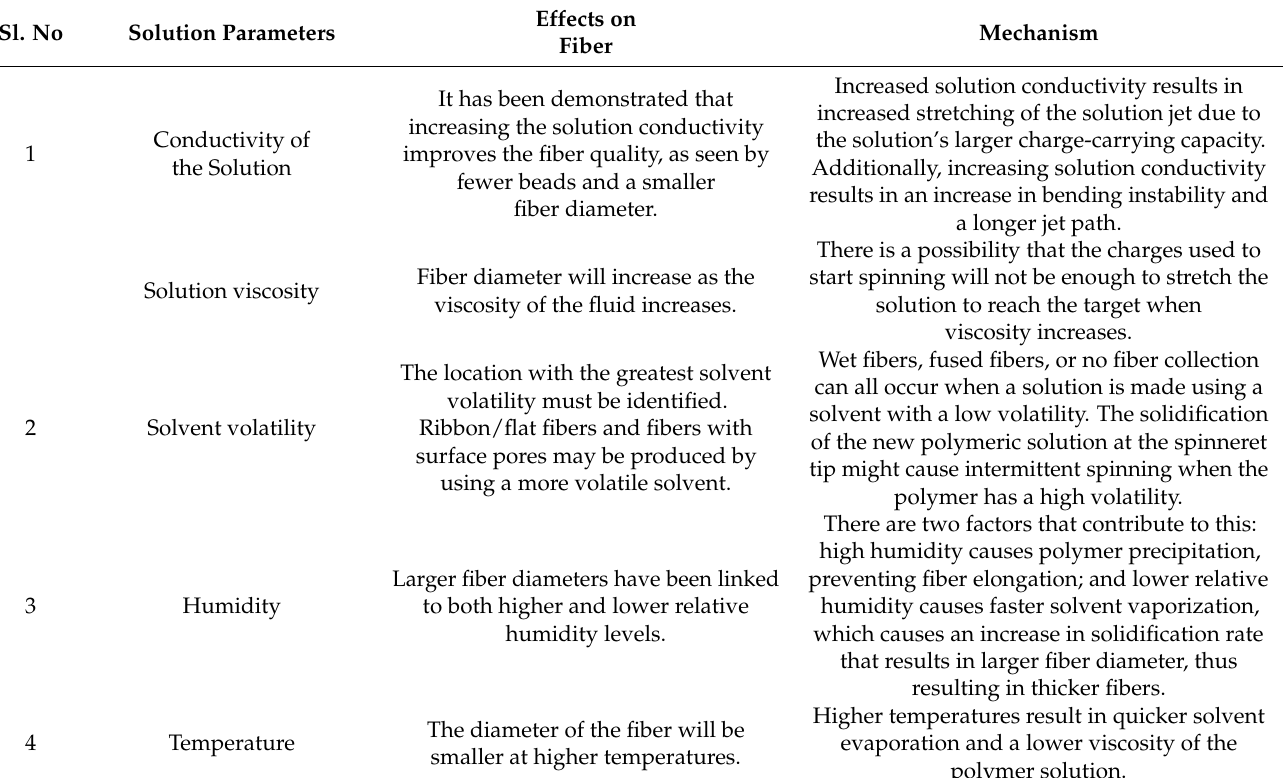
Table 6. Solution parameter and its